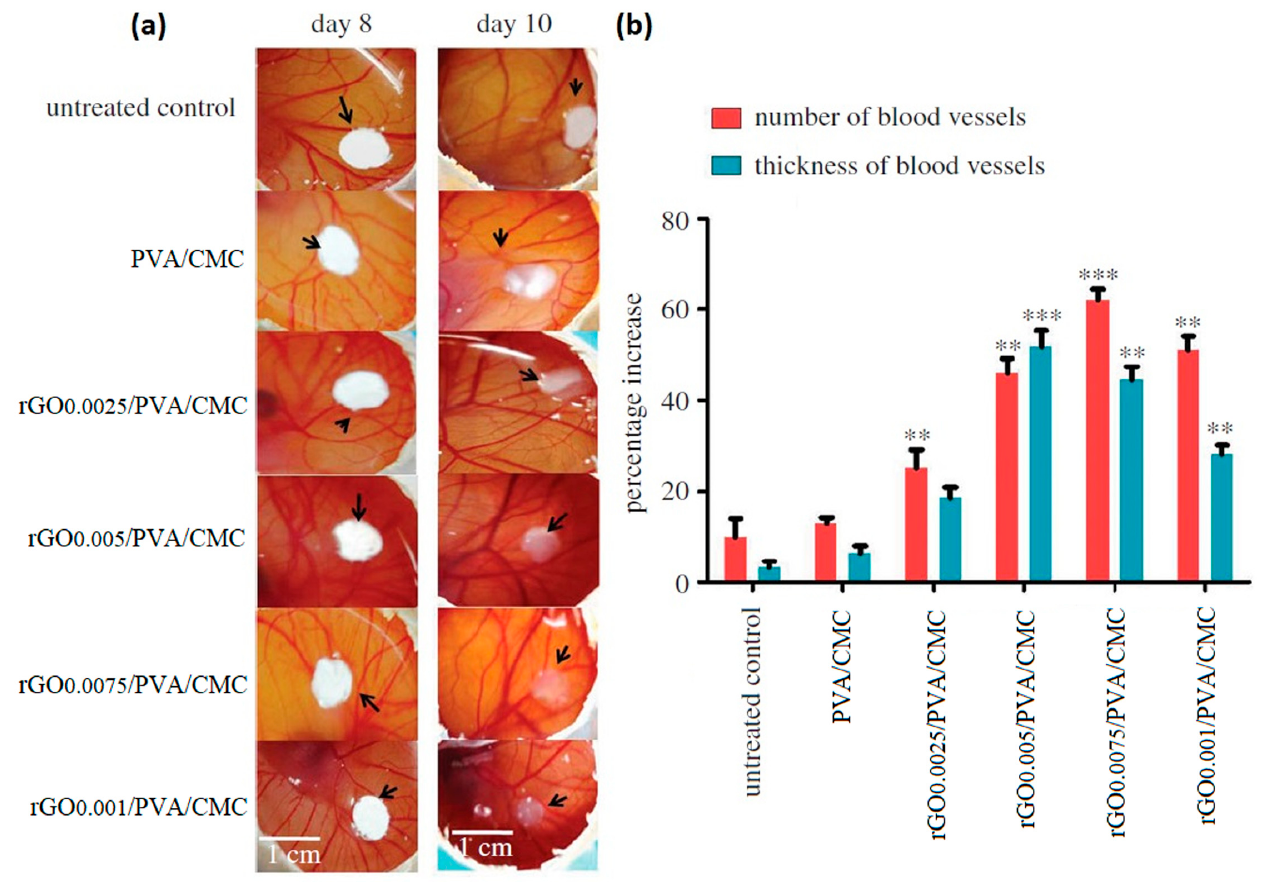
Figure 8. ( a ) Digital photos of chick chorioallantoic membrane (CAM) model untreated and treated with PVA/CMC and PVA/CMC with 0.0025, 0.005, 0.0075 and 0.01% w / v rGO; ( b ) percentage increase in the number (red bars) and (green bars) blood vessels after 10 days of CAM model (the value are normalised to untreated control at 8 days, ** p < 0.01, *** p < 0.001 vs. control). Adapted from